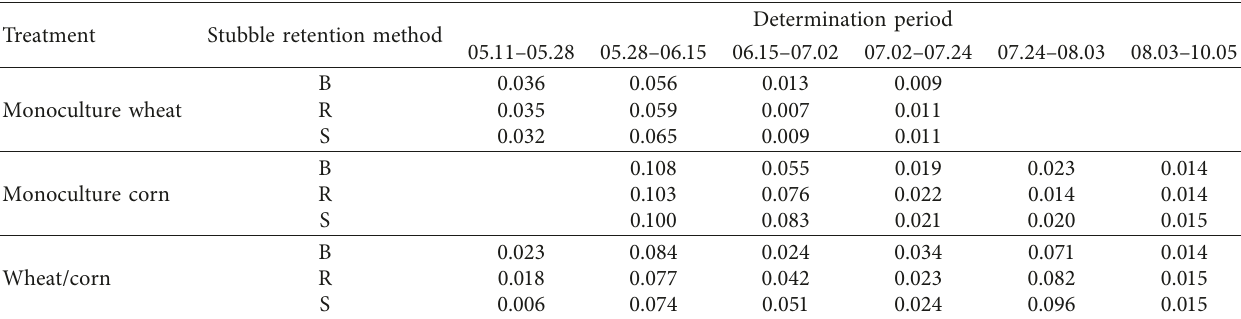
Table 4: Effects of stubble retention methods on relative growth rate of